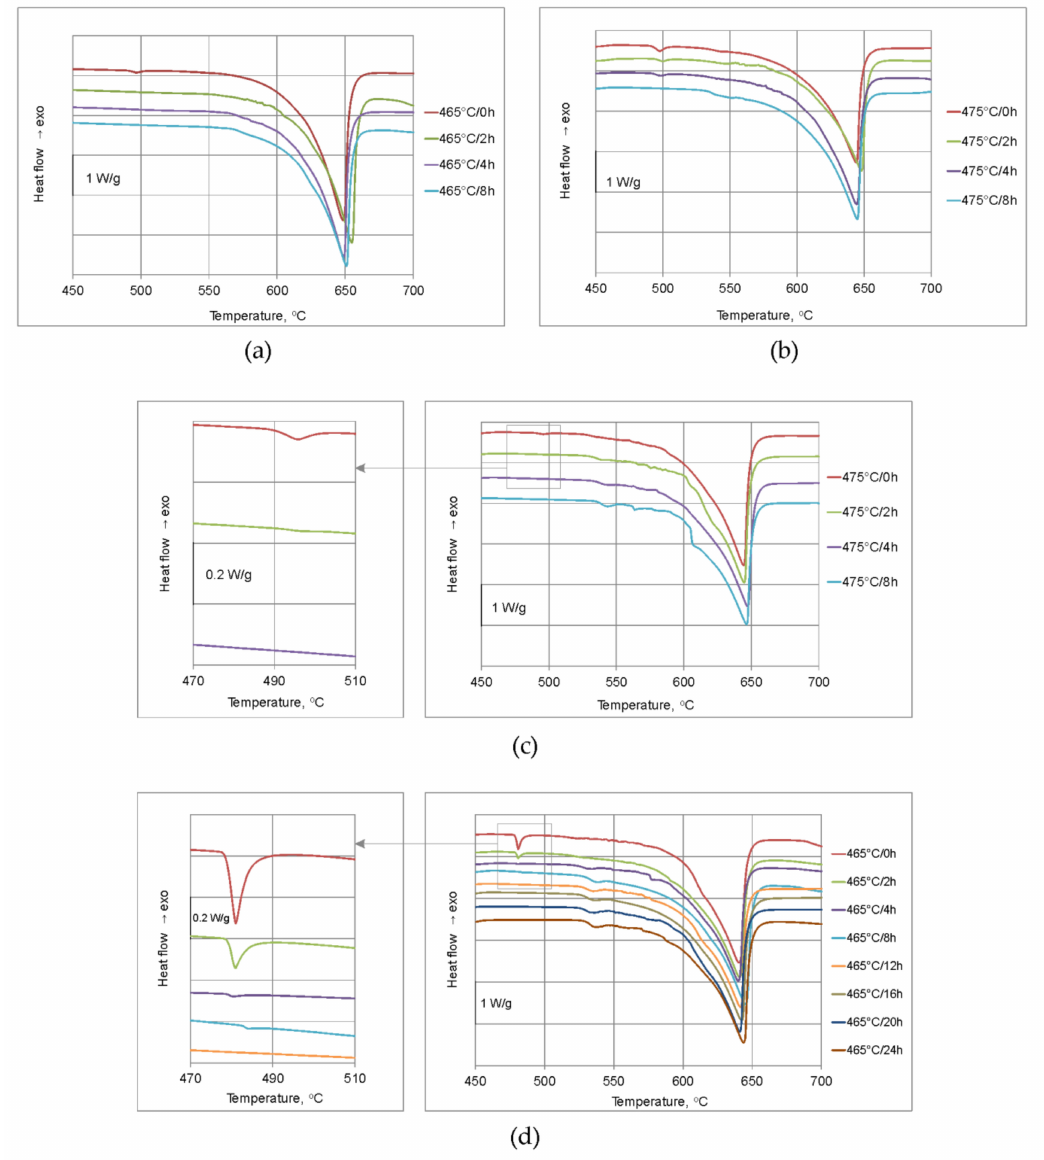
Figure 4. Exemplary DSC (Differential Scanning Calorimetry) curves of alloys subjected to homogenization: ( a ) 7075 alloy 1, standard homogenization; ( b ) 7075 alloy 2, high-temperature homogenization; ( c ) 7075 alloy 3, high-temperature homogenization; ( d ) 7049 alloy 4, standard